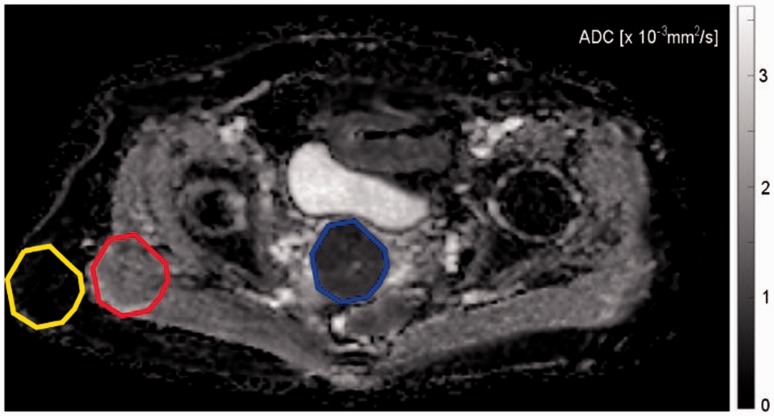
Exemplary ROI definition in a 43-year-old patient with a G2 squamous cell carcinoma of the cervix (FIGO stage IB2, T3aN1M0). The ROIs are color coded for better visibility: Blue = tumor, red = gluteal muscle, yellow = subcutaneous fat. The latter two ROIs are copies of the first one, identical in shape and size.